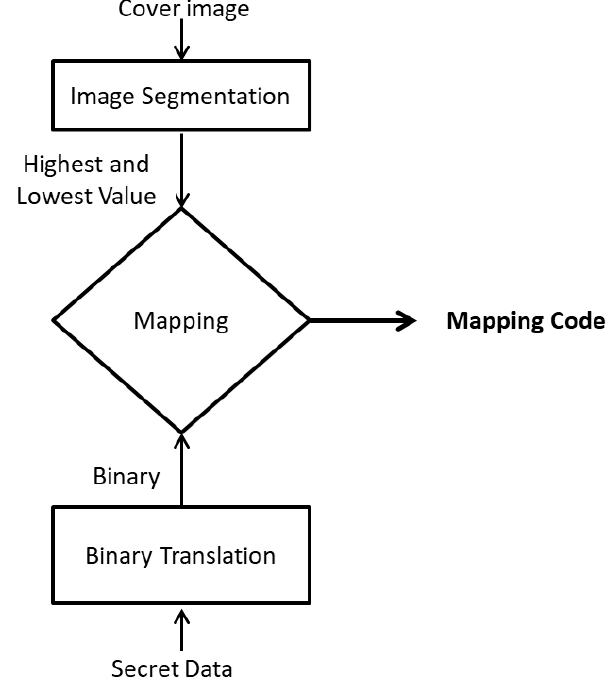
Figure 1. Flowchart of the proposed CIHLHF .